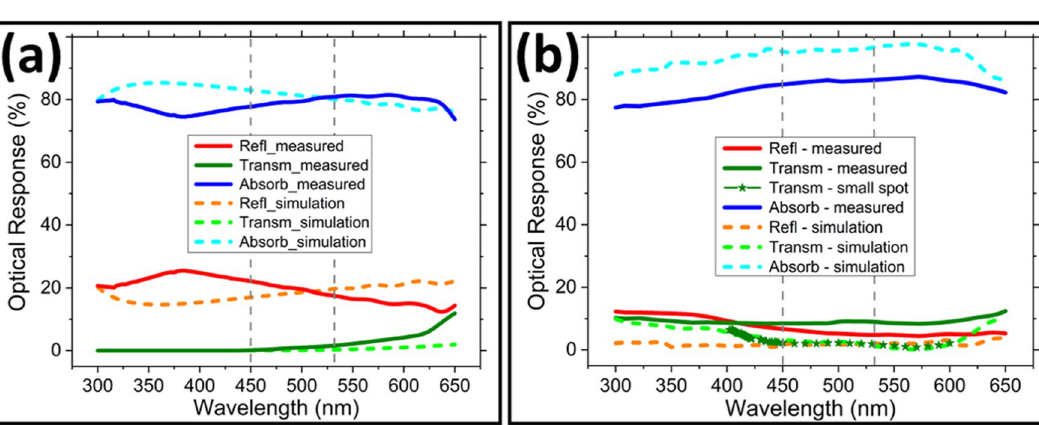
Figure 4. The optical properties (total reflectance, transmittance, and absorbance) for GaInP structures embedded in PDMS. ( a ) Simulated optical response for a 1 µm-thick semi-infinite thin film layer (slab). The ‘measured’ optical response for the micro-square (MS) arrays embedded in PDMS is included. This data is corrected for a fill factor of 100%. ( b ) Simulated and measured optical response for the tapered nanowire (NW) arrays embedded in PDMS. Measured transmittance using a small spot set-up is also included (dark green shows the simulated optical response for an infinite 1 µm-thick film (slab) embedded in PDMS. The simulation data shows that an absorbance of ~ 80% can be obtained for the embedded GaInP slab at source wavelengths of 450 and 532 nm; the absorbance is mainly limited by surface reflection which is ~ 20% at these wavelengths. The simulated result for the slab can be taken as a reference to compare the structured (MS or tapered NW array) converter layers. Figure 4a also shows the measured data for the MS array, corrected for the surface fill factor (FF) of the semiconductor (~ 49%). Although some light is transmitted through the gaps and the boundaries of the MSs also scatter light, approximating the MS array to a slab gives some qualitative information for comparison. As seen in Fig. 4a the measured and simulated data are within 10% in the full wavelength range. Figure 4b shows the measured and simulated optical response for the tapered GaInP NW (AvD ≈ 250 nm) arrays embedded in PDMS. The observed trends in the measured and simulated optical response are in very good qualitative agree- ment. The simulated data for the tapered NW arrays (modelled after the fabricated tapered NW shapes) shows very high absorbance, more than 95% at 450 and 532 nm source wavelengths. Correspondingly, the measured absorbance is ~ 85%. Since the tapered NW dimension and shape used in the simulations correspond to the